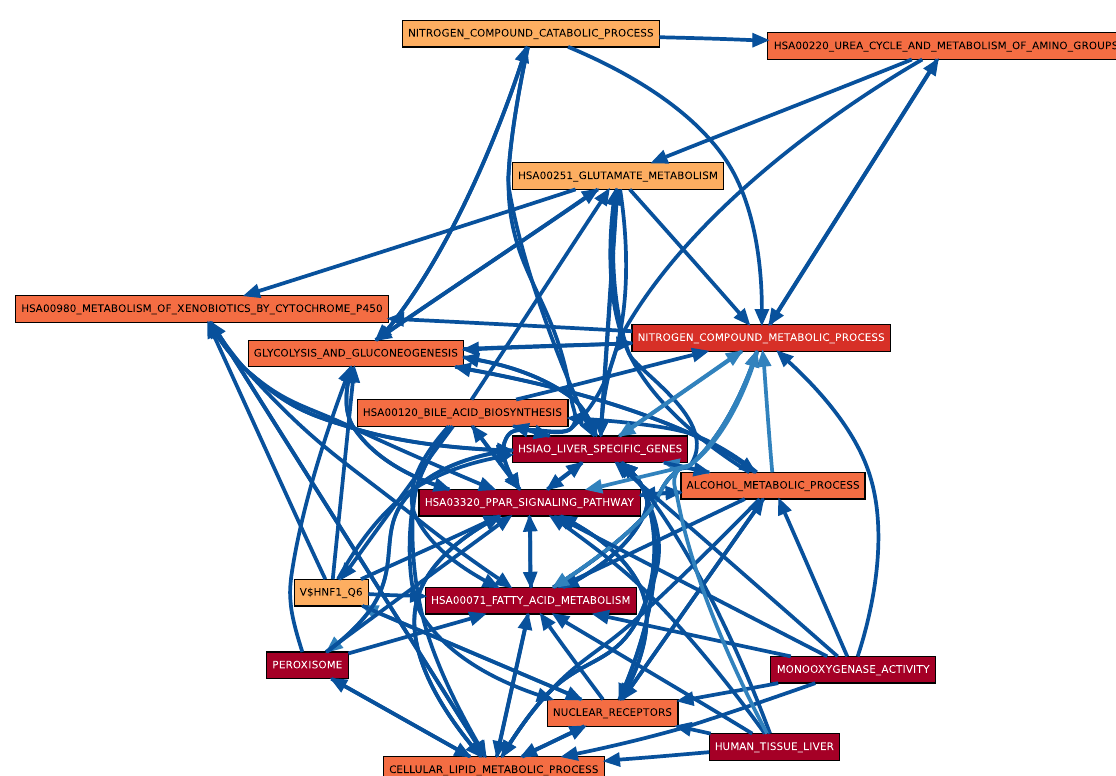
Figure 5. Context-free BPLN, constructed using the approach of Dotan-Cohen etal. [ 8 ] . Colors of gene sets represent perturbation measured by GSEA for CS versus HM at day 8. Note that these perturbation values did not factor into the computation of the BPLN; we display them only for the purpose of visual comparison with Figures 1–4.